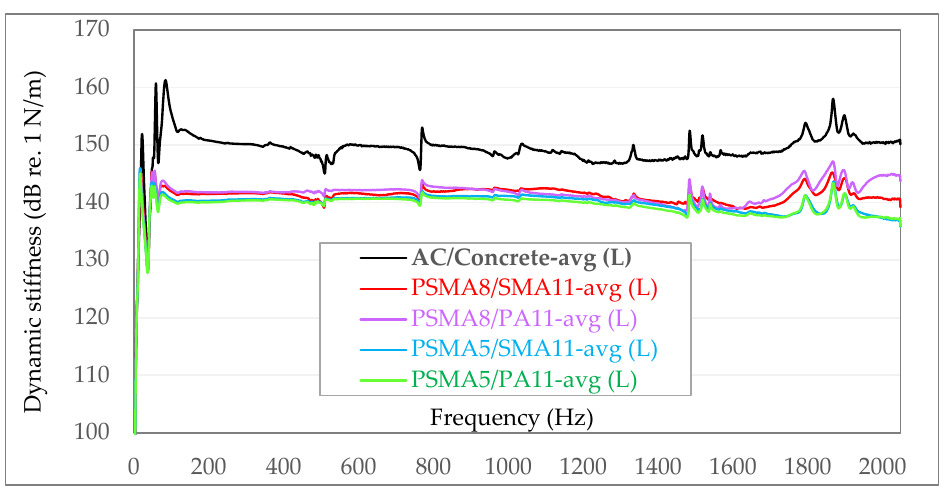
Figure 11. Summary of averaged values of dynamic stiffness from individual measurement series for in situ measurements (S).